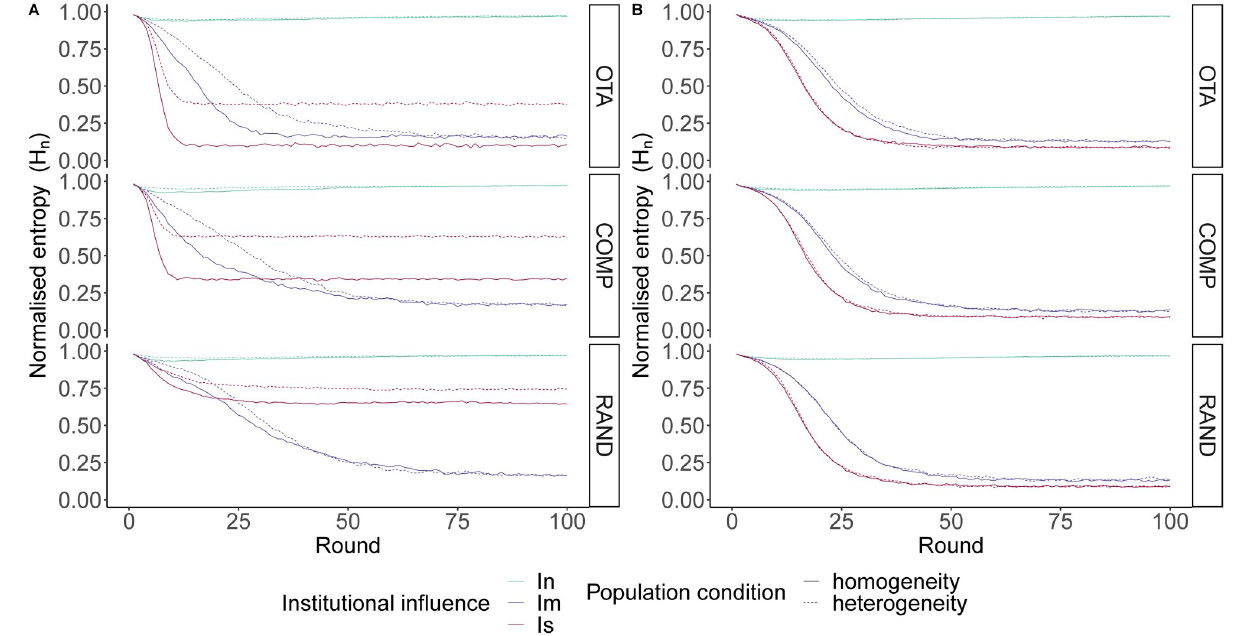
Fig 6. Diversity of opinions in 100-agent micro-societies, averaged over each level of institutional influence, level of population homogeneity and value system at β = 0.5. A: Value-aggregating institution; B: Opinion-aggregating institution. Results from these controlled simulations are qualitatively similar to the results presented above using 10-agent